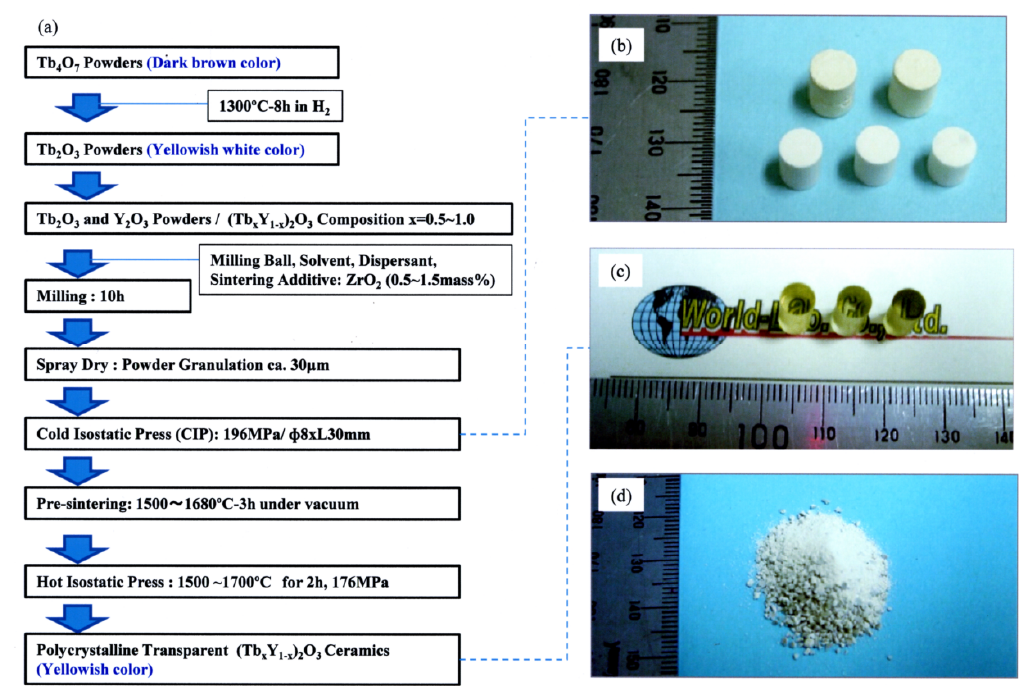
Figure 1. ( a ) Fabrication process for (Tb x Y 1 − x ) 2 O 3 ceramics derived from Tb 2 O 3 and Y 2 O 3 raw powders; ( b ) powder compacts after the cold isostatic press (CIP) process; ( c ) transparent sintered bodies with ZrO 2 additives after hot isostatic press (HIP) treatment; ( d ) crushed sintered bodies without ZrO 2 additives after sintering.